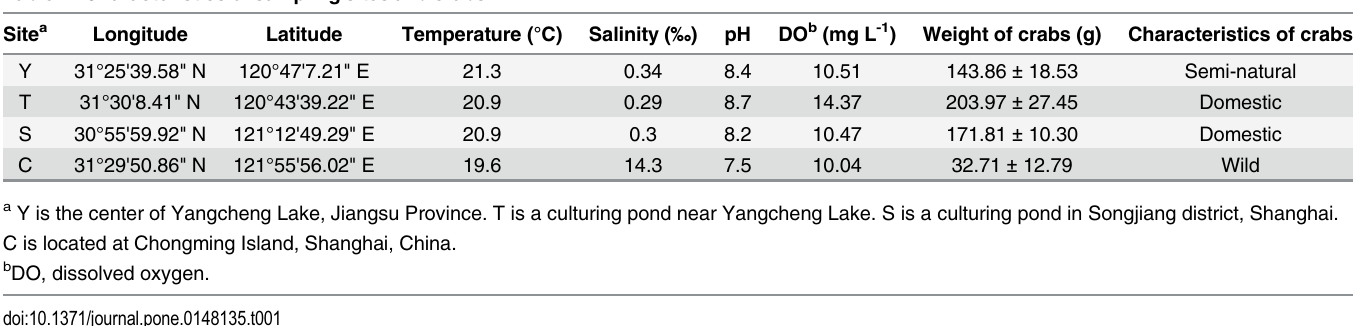
Table 1. Characteristics of sampling sites and